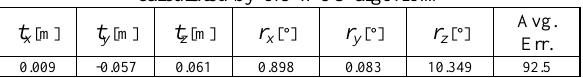
Table 6: Transformation